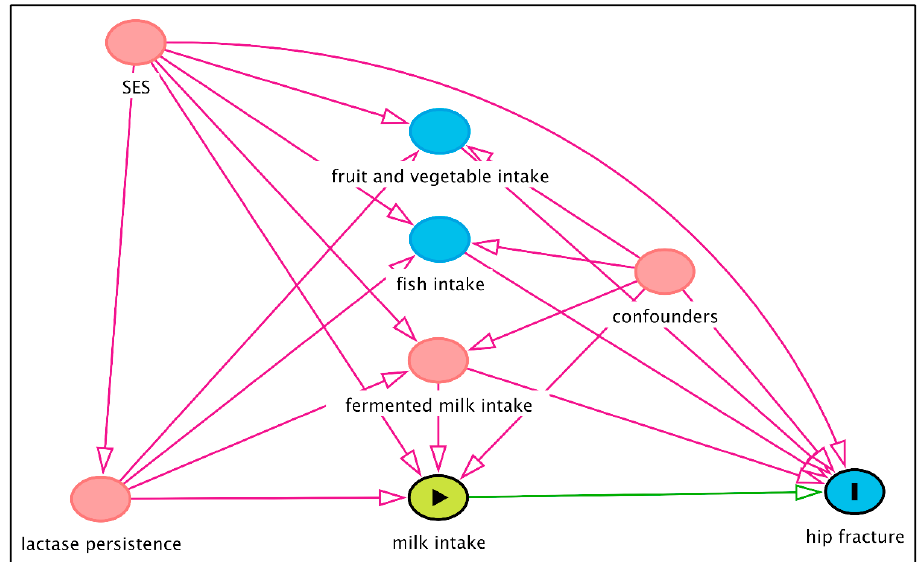
Figure 4. Causal diagram illustrating violations of the underlying assumptions for a Mendelian randomisation study of the causal effect of the milk intake on hip fractures using the MCM6 C/T SNP (rs4988235), here denoted “lactase persistence”, as an instrumental variable for the milk intake: probable horizontal pleiotropic effects of lactase persistence through other biological pathways and potential confounding by socioeconomic status (SES). The causal diagram was created using DAGitty.net [124].